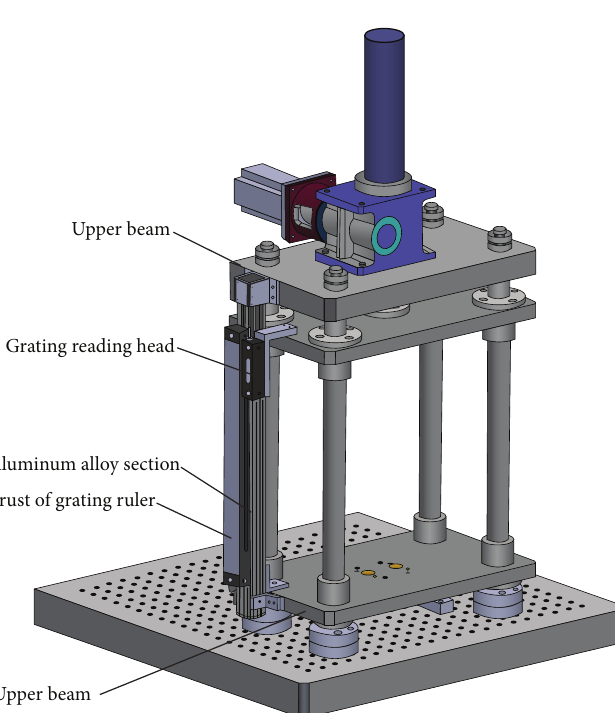
Figure 8: The scheme of measuring displacement.